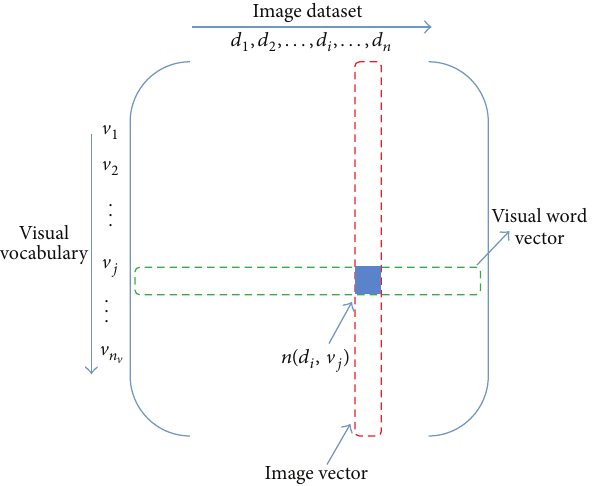
Figure 3: The “image visual-word” matrix of the image low-level